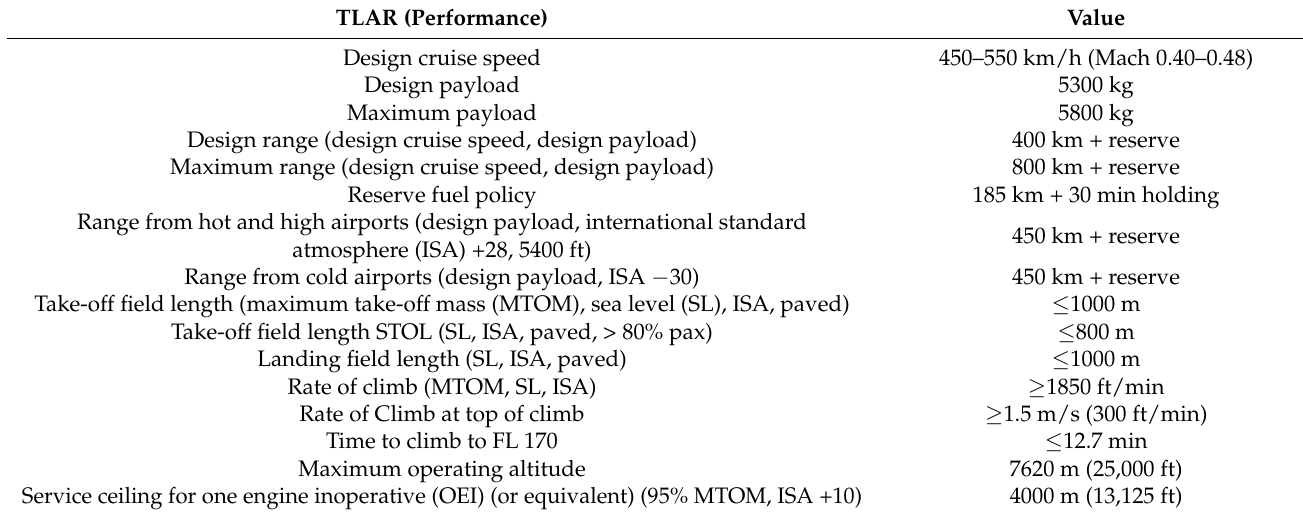
Table 4. Top-level aircraft requirements with regard to